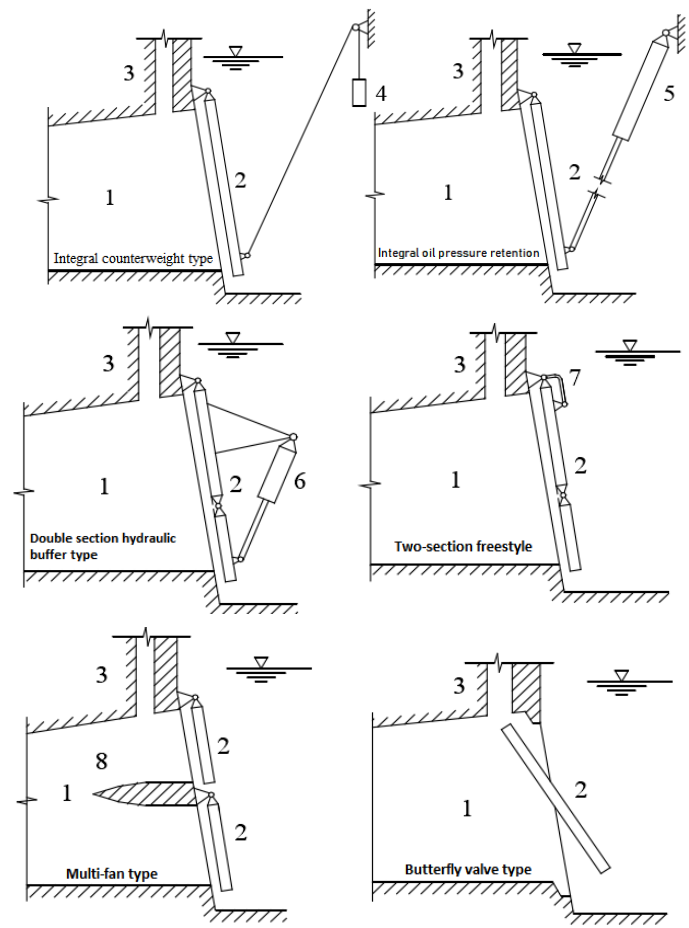
Figure 10. Diagram of flap valve types [68]. 1 — Outlet channel, 2 — Flap valve, 3 — Vent, 4 — Coun- terweight, 5 — Buffer cylinder, 6 — Buffer water cylinder, 7 — Rocker arm hinge link, and 8 — Dia- phragm